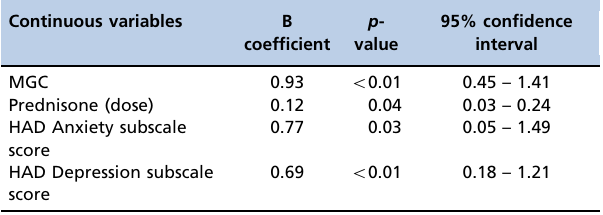
Table 5 - Multivariate linear regression analysis of MG-QOL15 scores representing the effect of each independent variable on